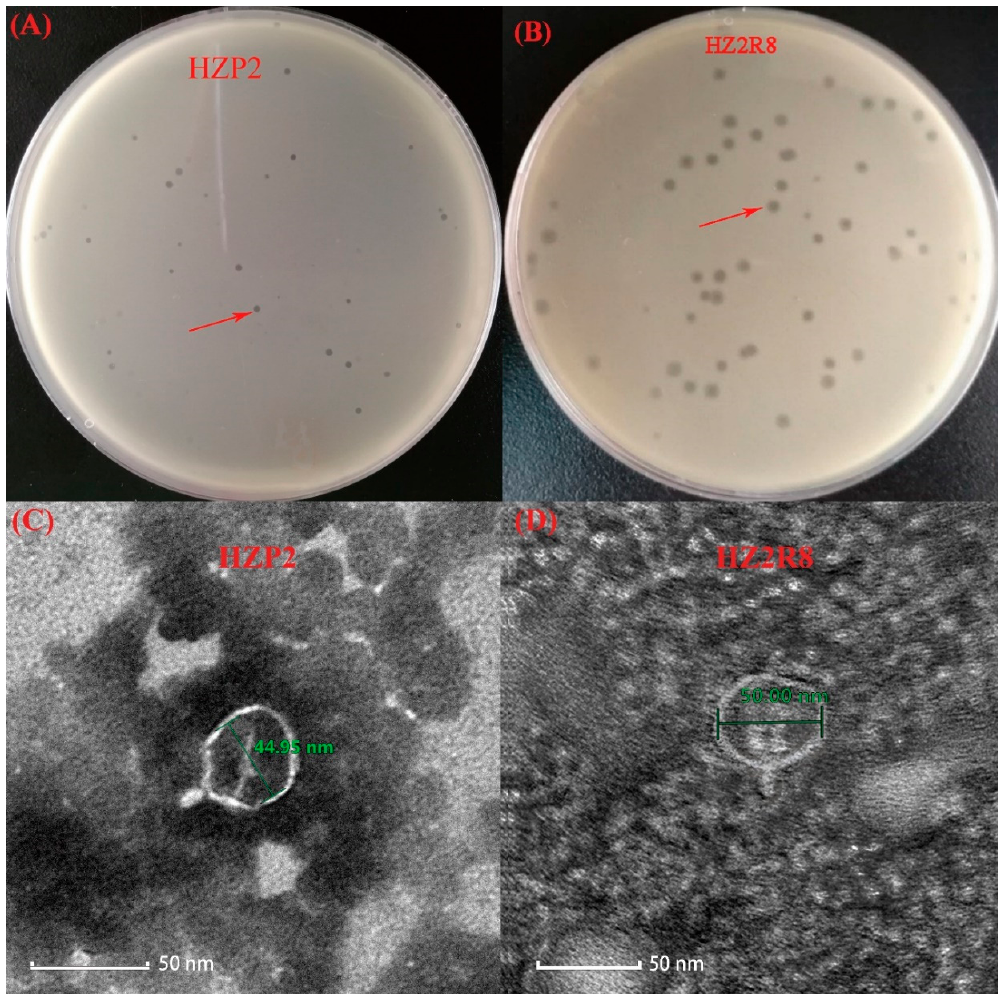
Figure 1. Isolated of phage HZP2 and HZ2R8. ( A ) Plaque morphology of phage HZP2. ( B ) Plaque morphology of phage HZ2R8. ( C ) Transmission electron microscopy of phage HZP2, where the scale bar represented 100 nm. ( D ) Transmission electron microscopy of phage HZ2R8, where the scale bar represented 50 nm.